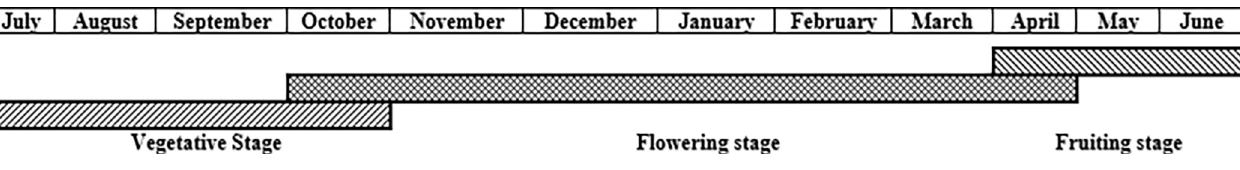
Fig 2. Duration of the different periods of the development stages of Rosmarinus officinalis